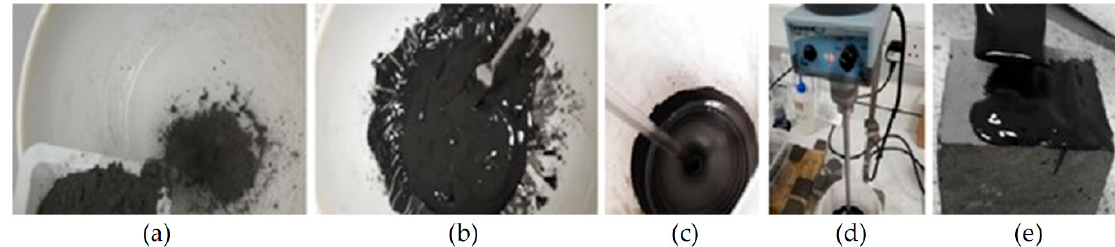
Figure 3. Geopolymer synthesis process: ( a ) adding fly ash powder into alkaline solution; ( b ) manually mixing the geopolymer binder by means of a spatula; ( c , d ) automatic mixing of the binder; ( e ) application of the binder onto concrete by means of a trowel.